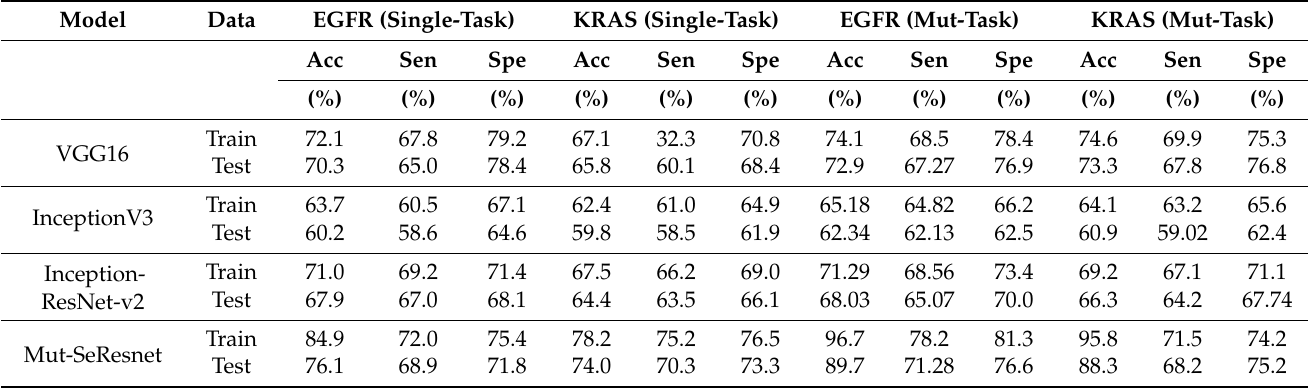
Table 4. Predictive performance of various deep methods on the